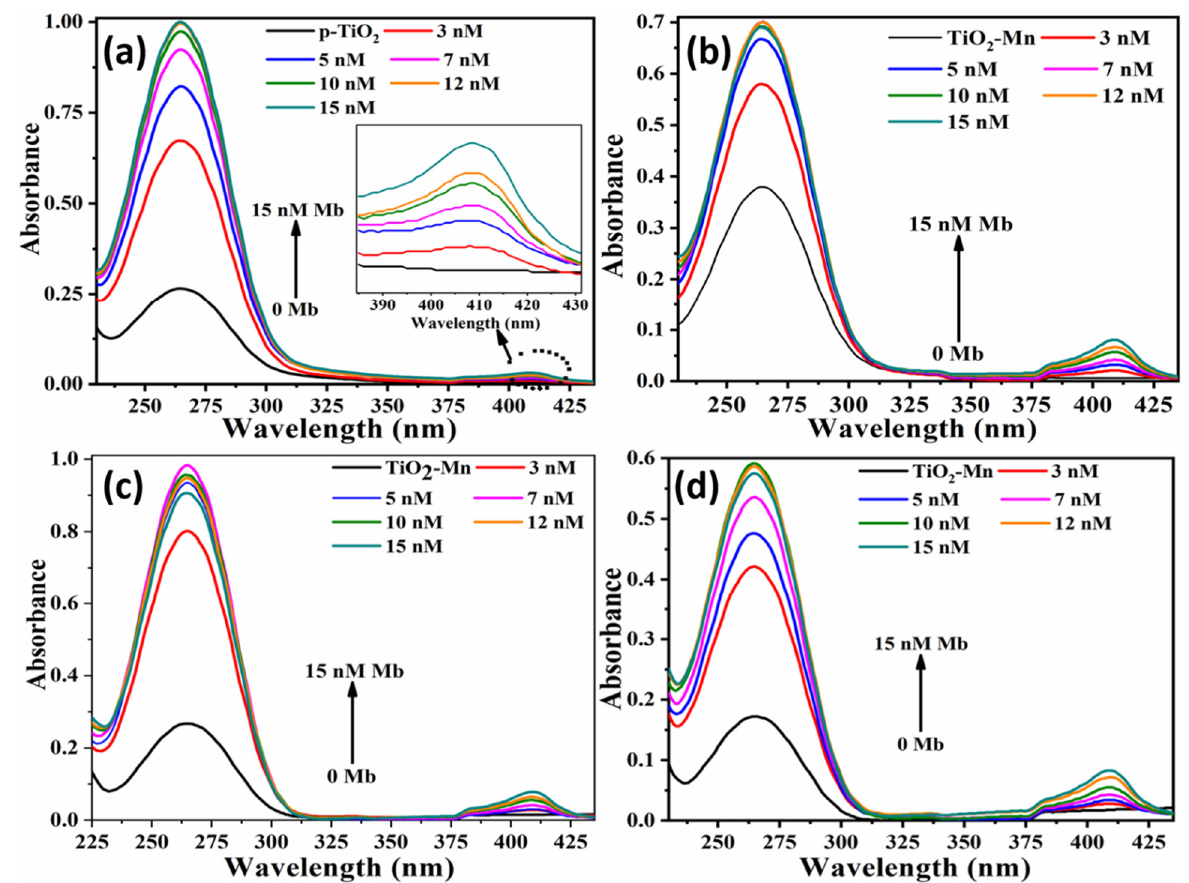
Figure 4. UV-Vis absorption spectra of pristine and Mn-doped TiO 2 nanoparticles with various Mb concentrations ( a ) Pristine TiO 2 ( b ) TiO 2 − Mn (13 × 10 17 atoms/cm 3 ) ( c ) TiO 2 − Mn (20 × 10 17 atoms/cm 3 ) ( d ) TiO 2 − Mn (32 × 10 17 atoms/cm 3 ).